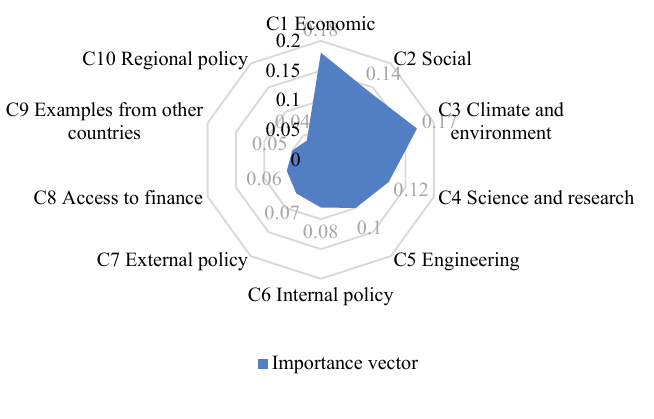
Fig. 2. The importance vector that shows the ranking of absolute importance